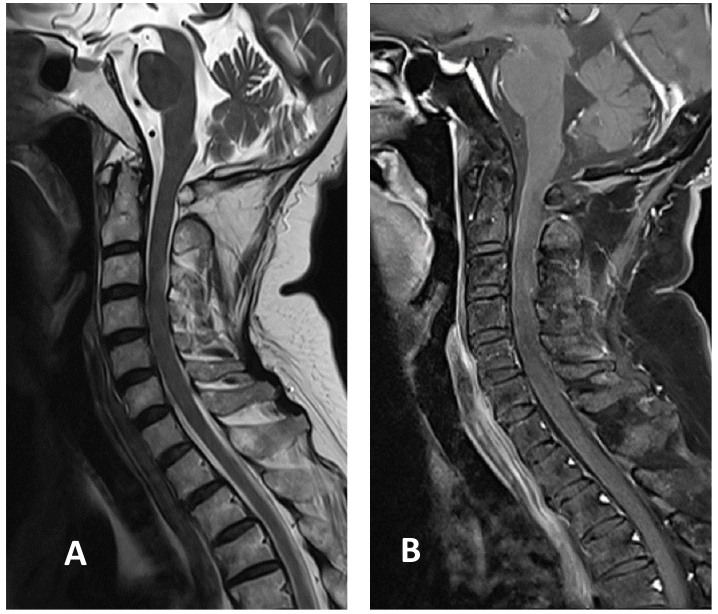
Figure 3. Cervical MRI images two weeks after discharge: ( A ) sagittal T2-weighted image showing the decreased size of hyperintensity in the cervical cord at the C3 level; ( B ) sagittal T1-weighted image with contrast showing minimal enhancement in the cervical cord at the C3 level.